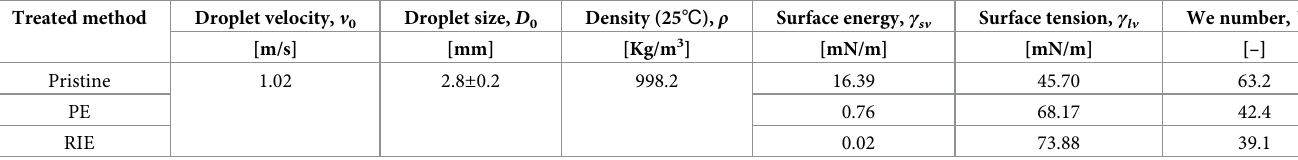
Table 2. Interface tension and We of the surface before and after